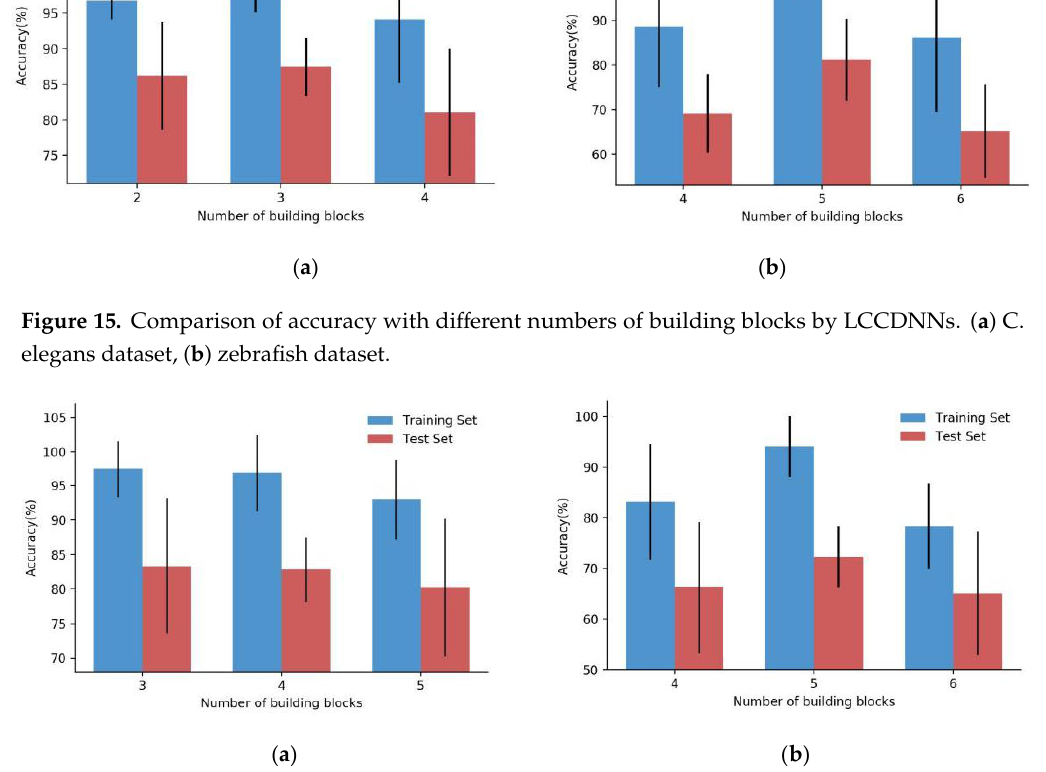
Figure 16. Comparison of accuracy with different numbers of building blocks by FCCDNNs. ( a ) C. elegans dataset, ( b ) zebrafish dataset.